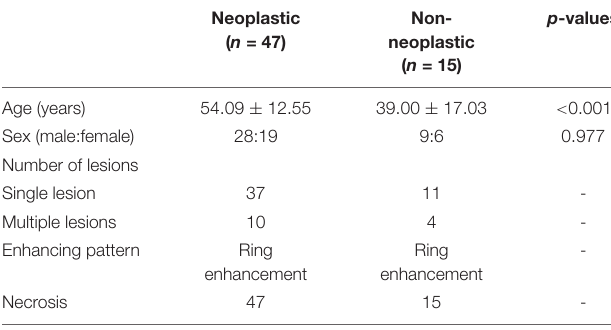
TABLE 1 | Clinical and MRI characteristics of